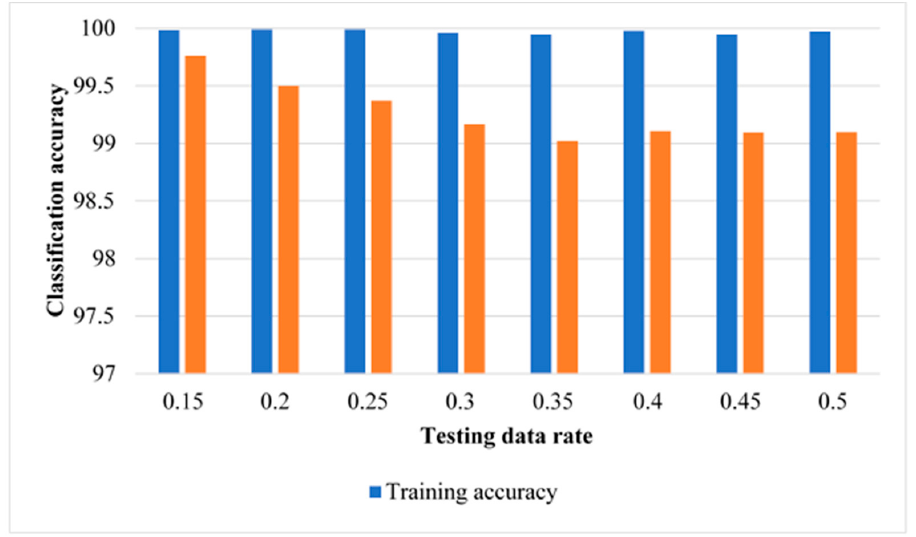
Figure 8. Classification results of training and testing data using MLR without data normalisation.